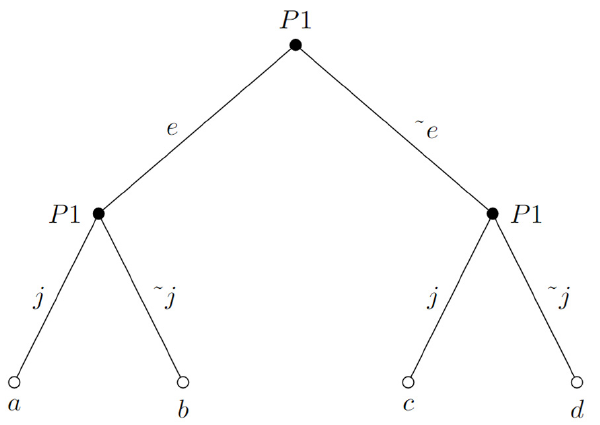
Figure 4. Full game tree of U.S. sanction choices, P 1: the United States, e : sanction of European natural gas imports, j : sanction of Japanese natural gas imports, ˜ indicates reverse moves.